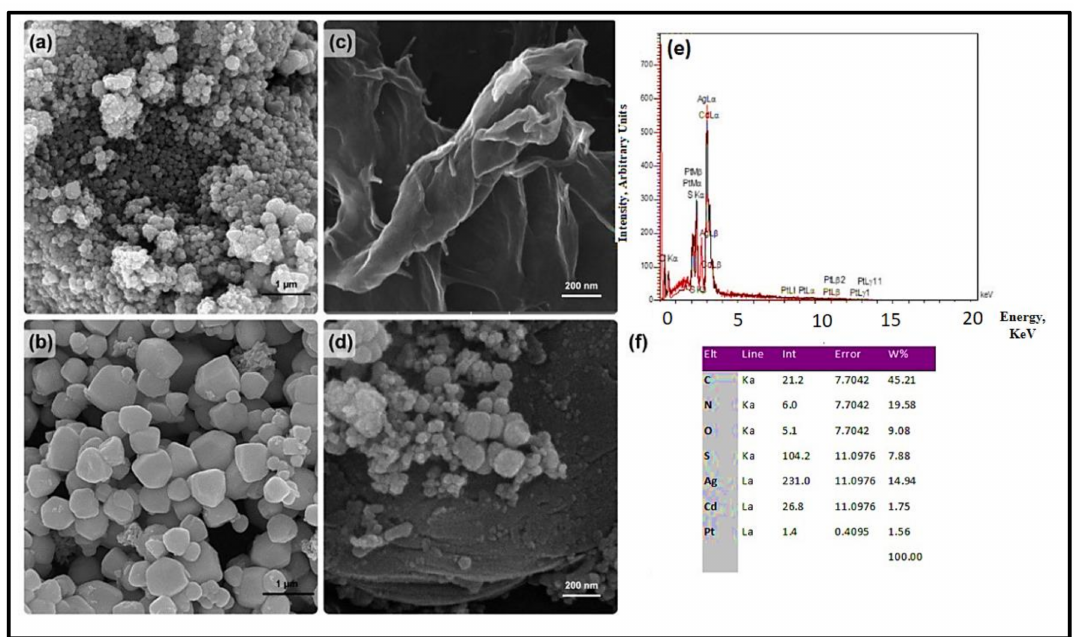
Figure 5. Field emission scanning electron microscope (FESEM) image of ( a ) CdS, ( b ) Ag 3 PO 4 , ( c ) chitosan, and ( d ) Pt-Ag 3 PO 4 / CdS / chitosan. ( e ) EDS spectrum of Pt-Ag 3 PO 4 / CdS / chitosan. ( f ) EDS table of Pt-Ag 3 PO 4 / CdS / chitosan.